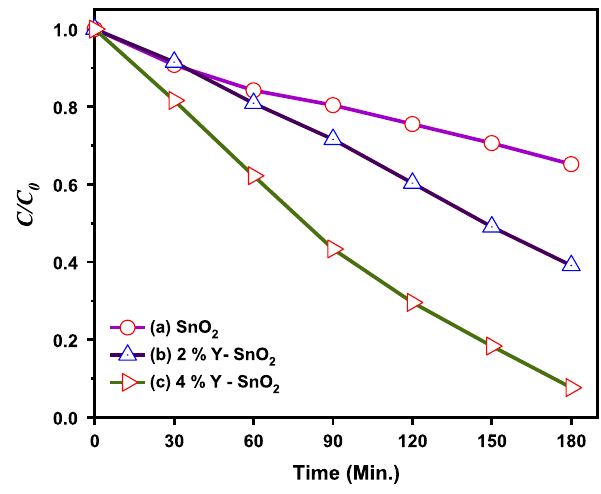
Fig. 8 Photocatalytic degradation of MB (a) SnO